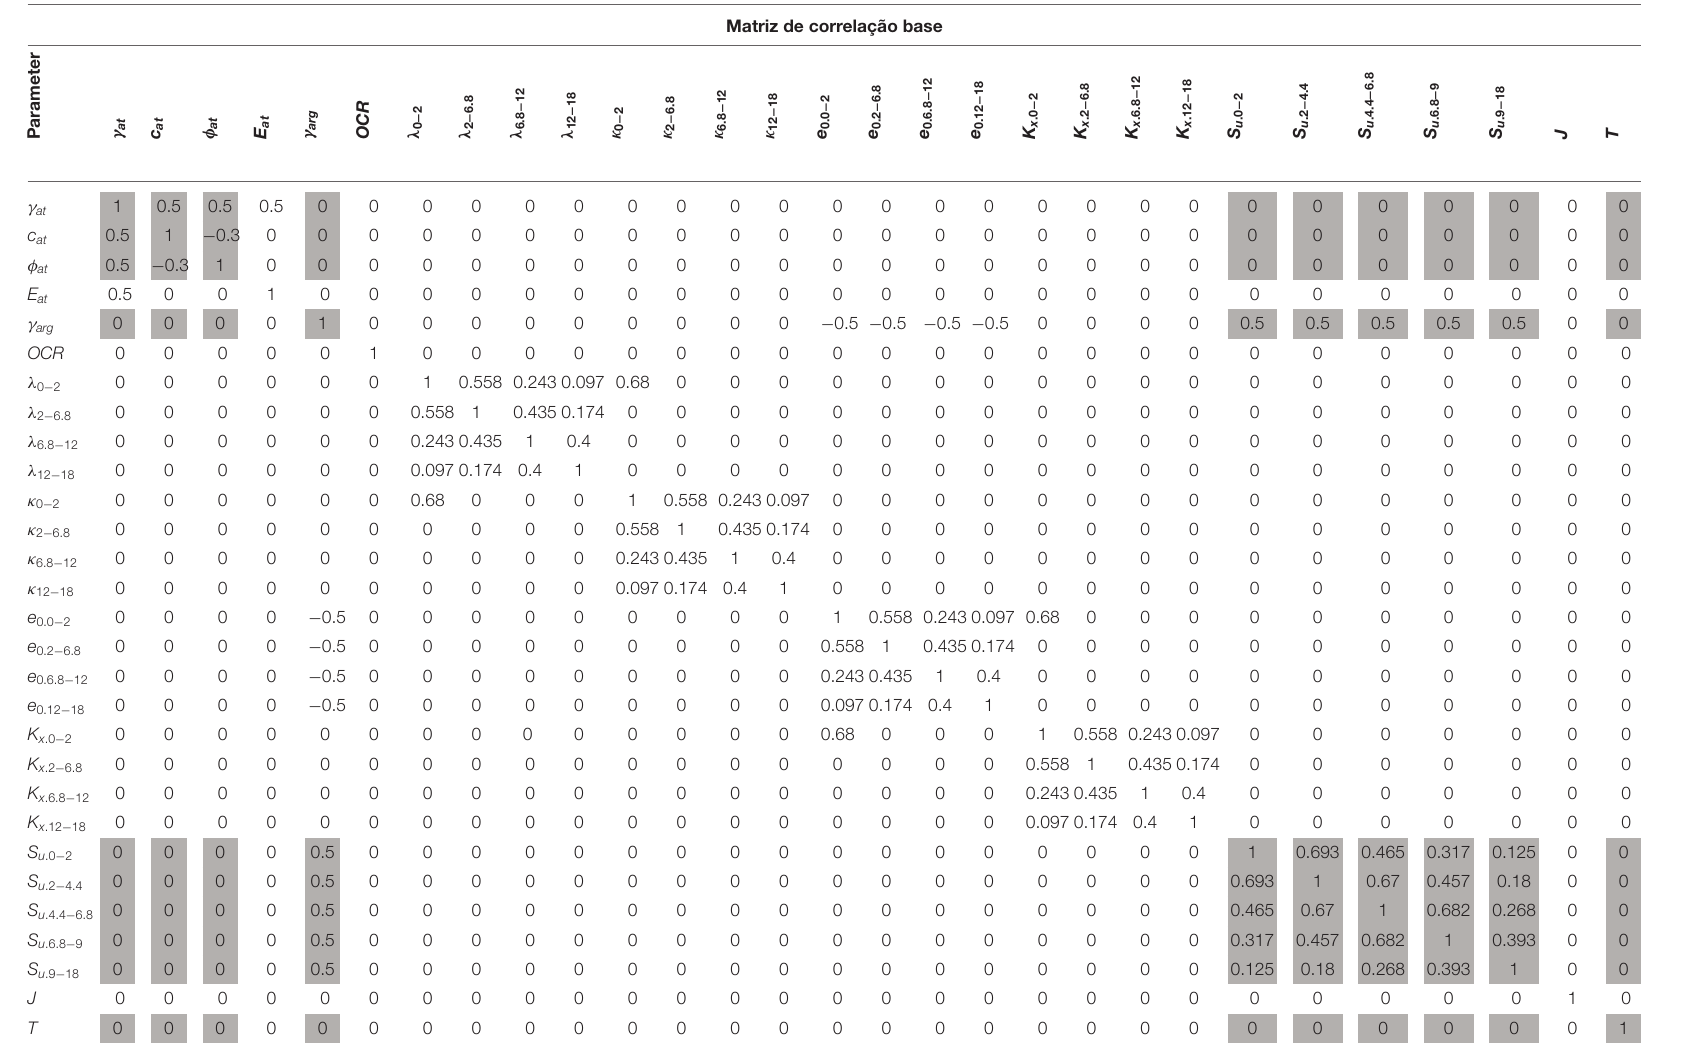
TABLE 5 | Basis correlation matrix for reliability analyses of the